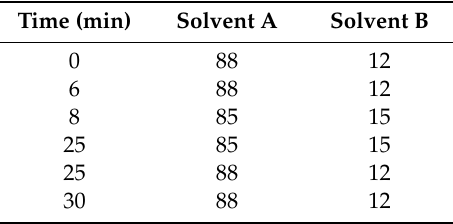
Table 5. Solvent system of anthocyanin analysis using HPLC analysis. Time (min) Solvent A Solvent